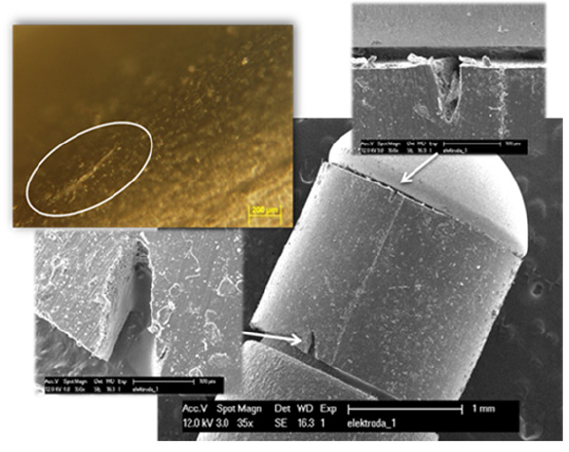
Figure 10: Damages to the electrode tip fixed with stent 2.